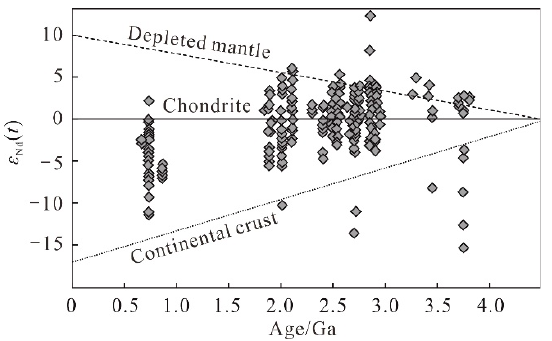
Figure 2. Summary of ε Nd(t) isotope data of BIFs through Earth’s history. Data of ε Nd(t) values of BIF is from [86–91].